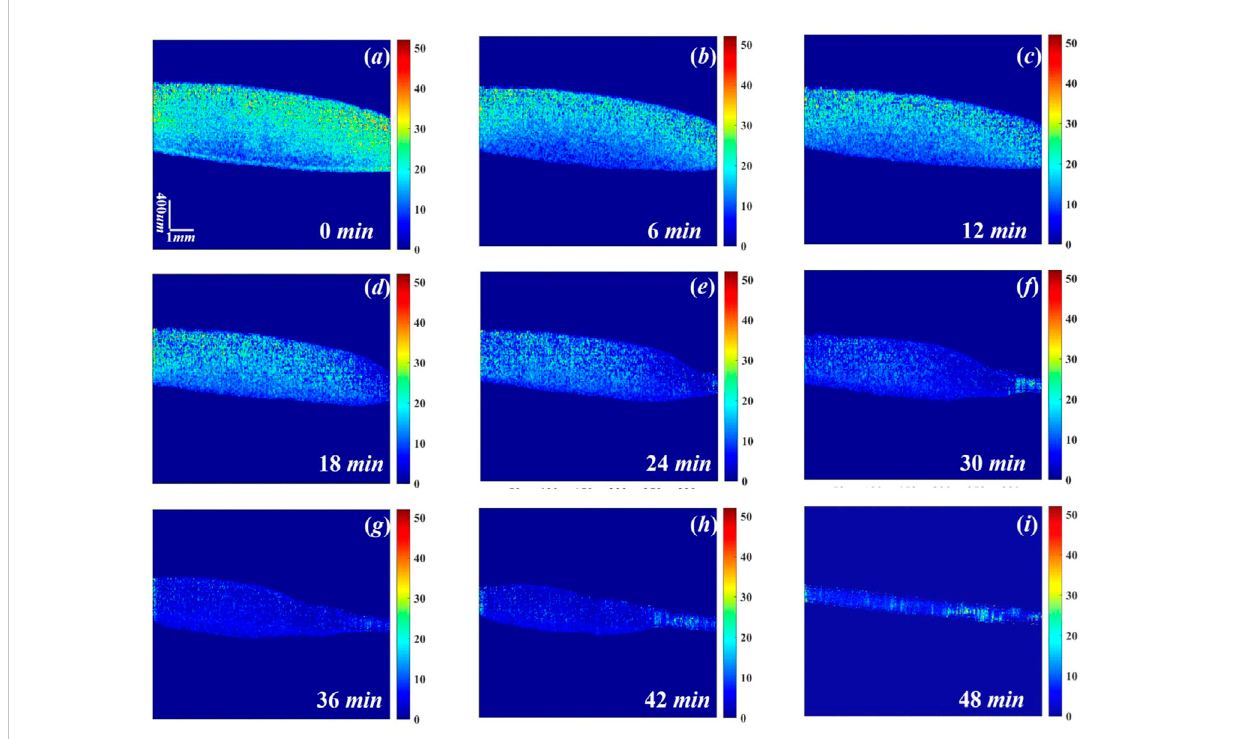
FIGURE 5 Corresponding cross-sectional speckle variance OCT image of whole blood during coagulation and drying processes with different delaying times of (A) 0 min, (B) 6 min, (C) 12 min, (D) 18 min, (E) 24 min, (F) 30 min, (G) 36 min, (H) 42 min, and (I) 48 min.